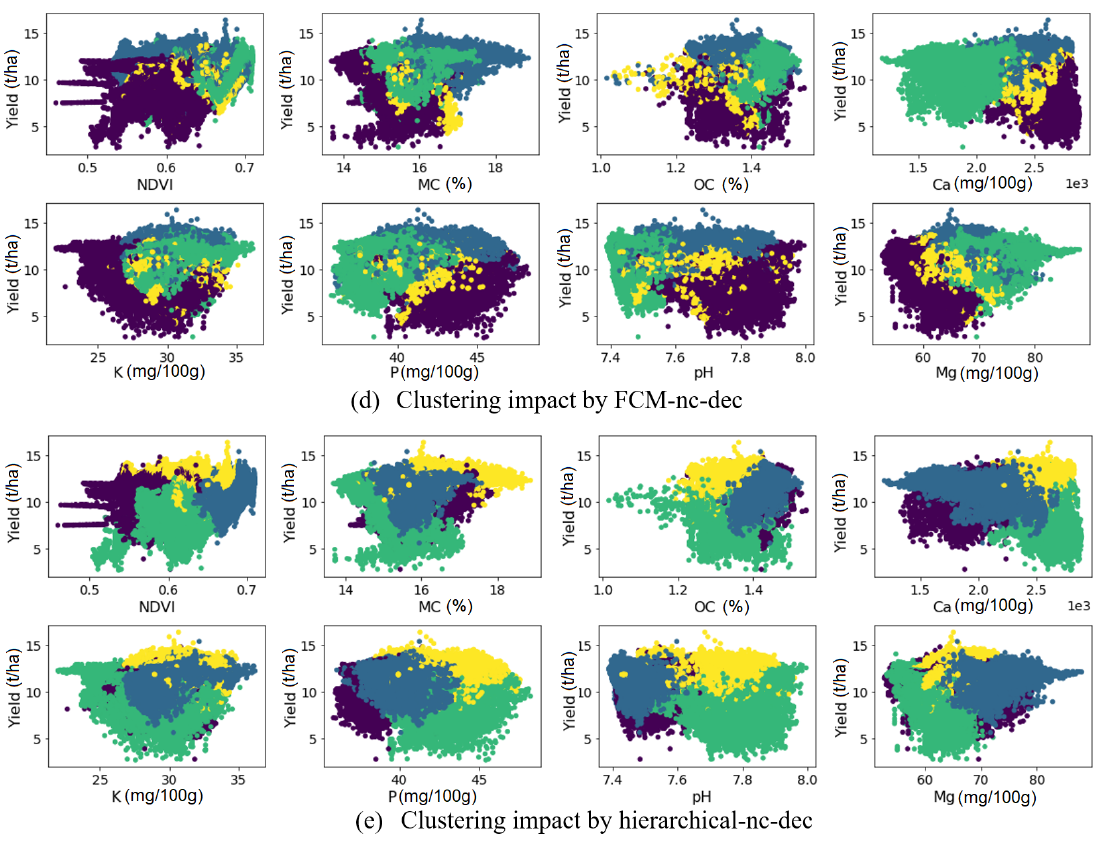
Figure 6. The impact of the clustering schemes on the scatter plot of yield vs. NDVI, and other soil attributes.